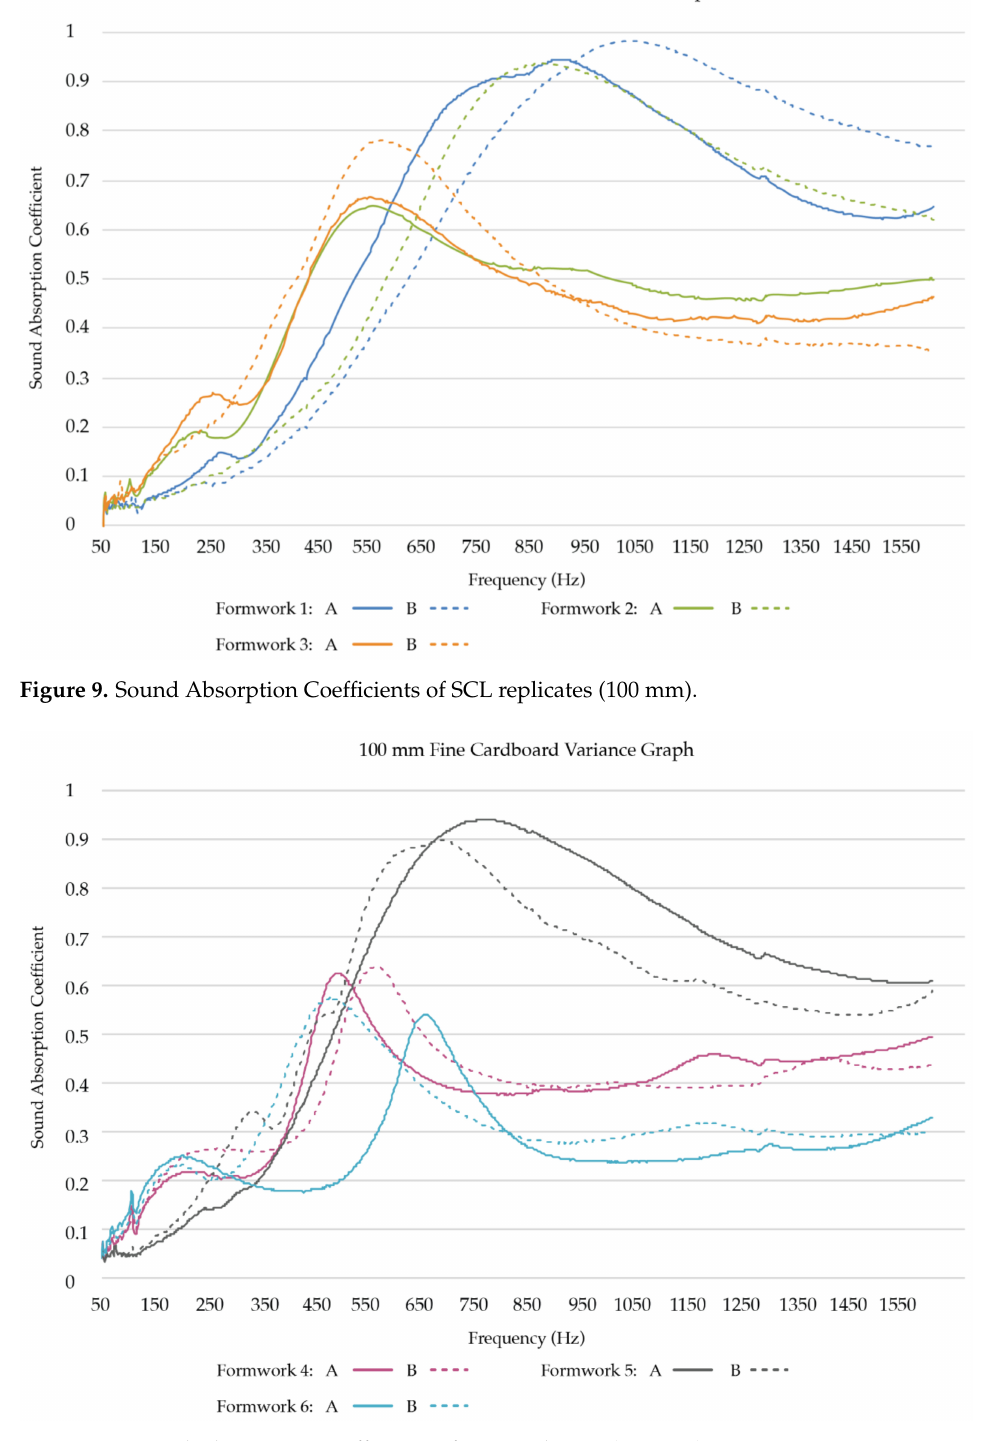
Figure 10. Sound Absorption Coefficients of FCL replicates (100